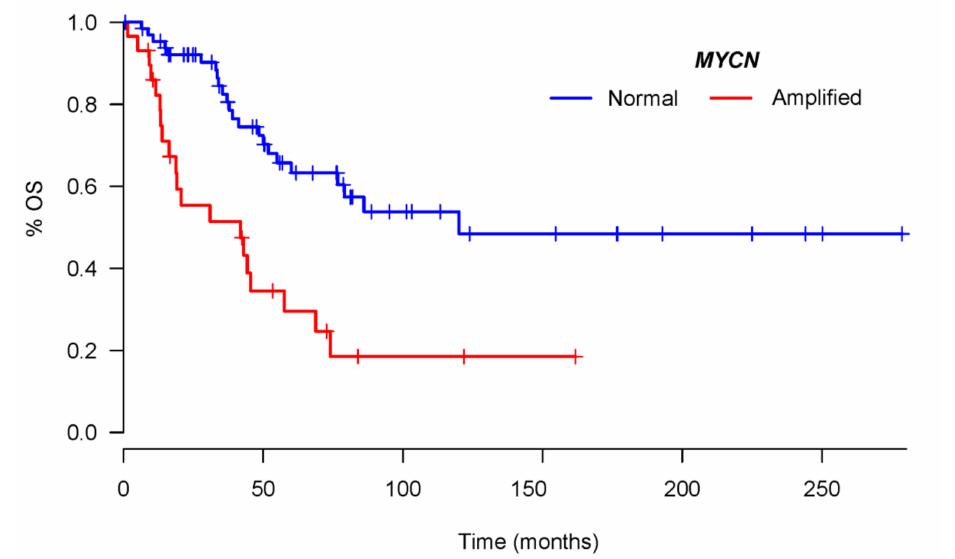
Figure A1. Overall Survival according to MYCN status. Kaplan-Meier survival curves of the whole study cohort (n = 95 NB patients, MYCN normal = 66, MYCN amplified = 29), continuous follow-up, censored